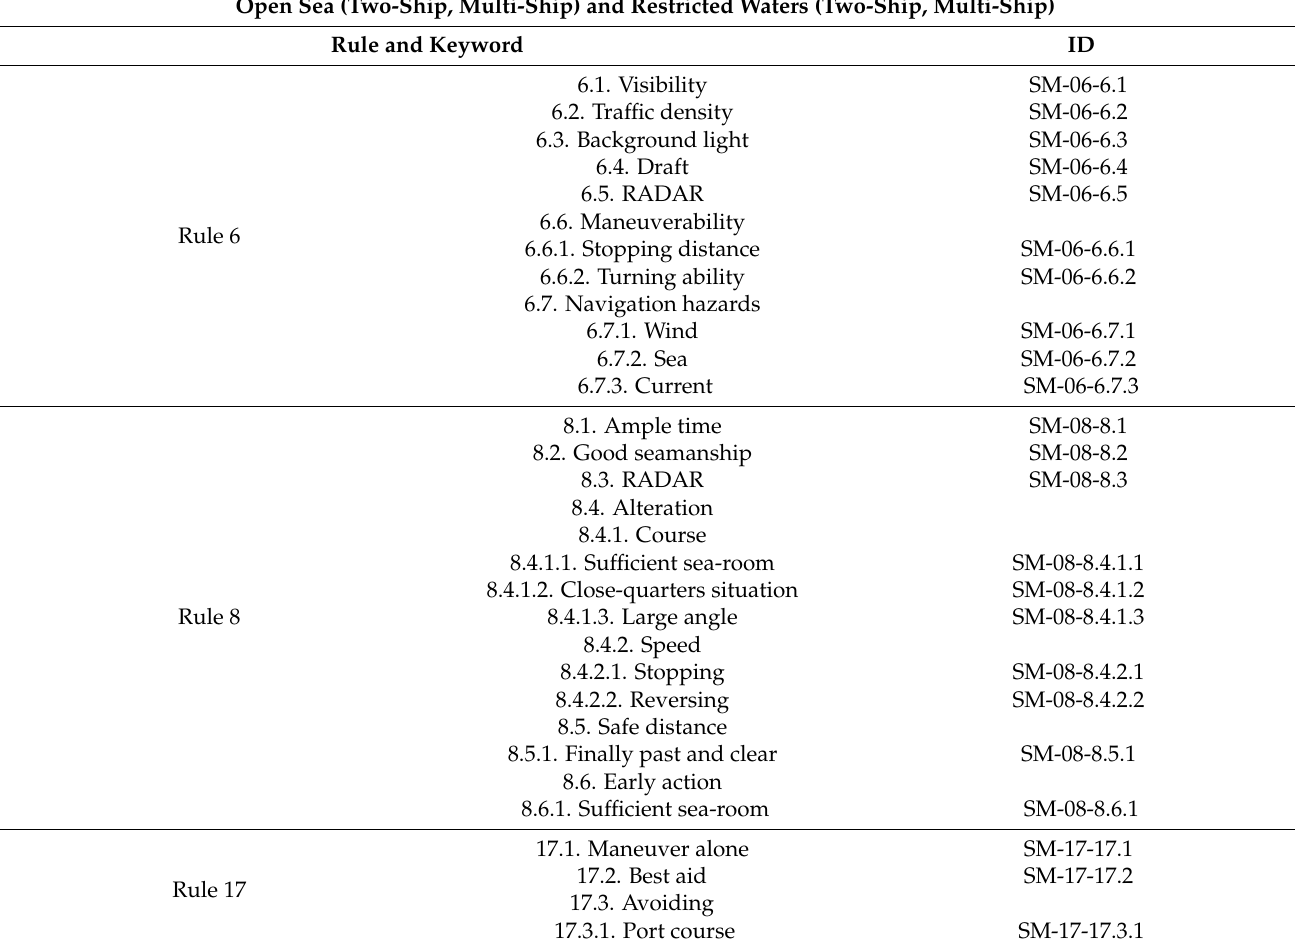
Table A3. Requirements specifications for ship